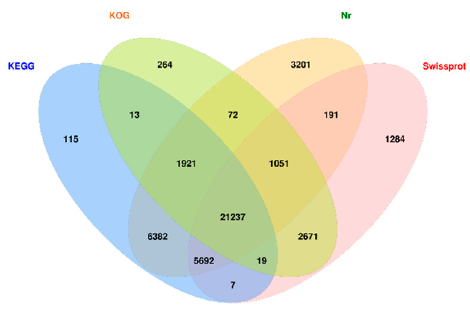
Figure 2. Annotated Venn diagram of unigenes in four databases.